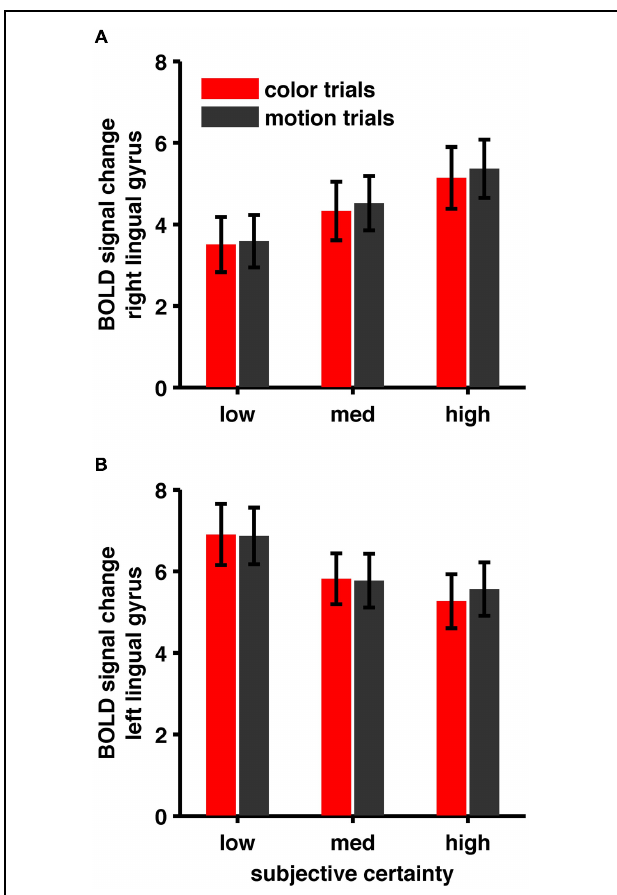
FIGURE 6 | (A) BOLD signal change in right lingual gyrus, (B) BOLD signal change in left lingual gyrus. Areas show opposite patterns. While BOLD signal in right lingual gyrus shows a positive correlation, BOLD signal in left lingual gyrus shows a negative correlation with subjective certainty